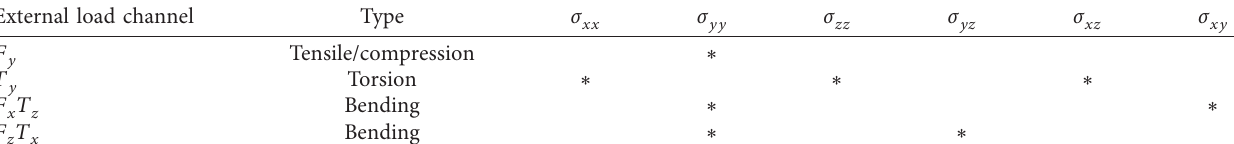
Table 2: Half-shaft local stress components under propagation of the external